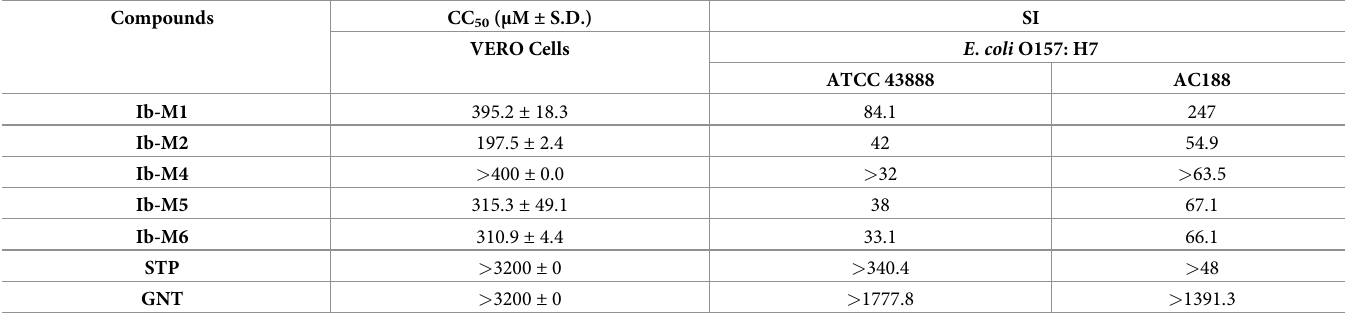
Each concentration was evaluated in triplicate in two independent experiments. The results are expressed in terms of the arithmetic average of each group ±